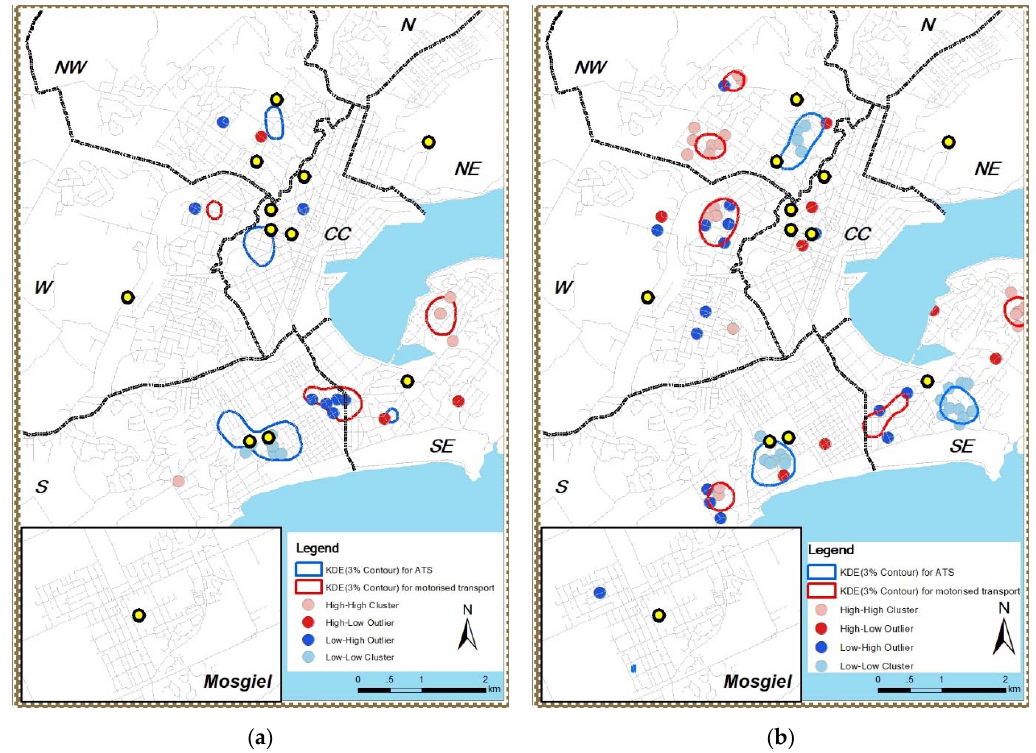
Figure 4. KDE and LISA transport modes distribution on vehicle ownership per household: ( a ) one vehicle per household; ( b ) two or more vehicles per household.